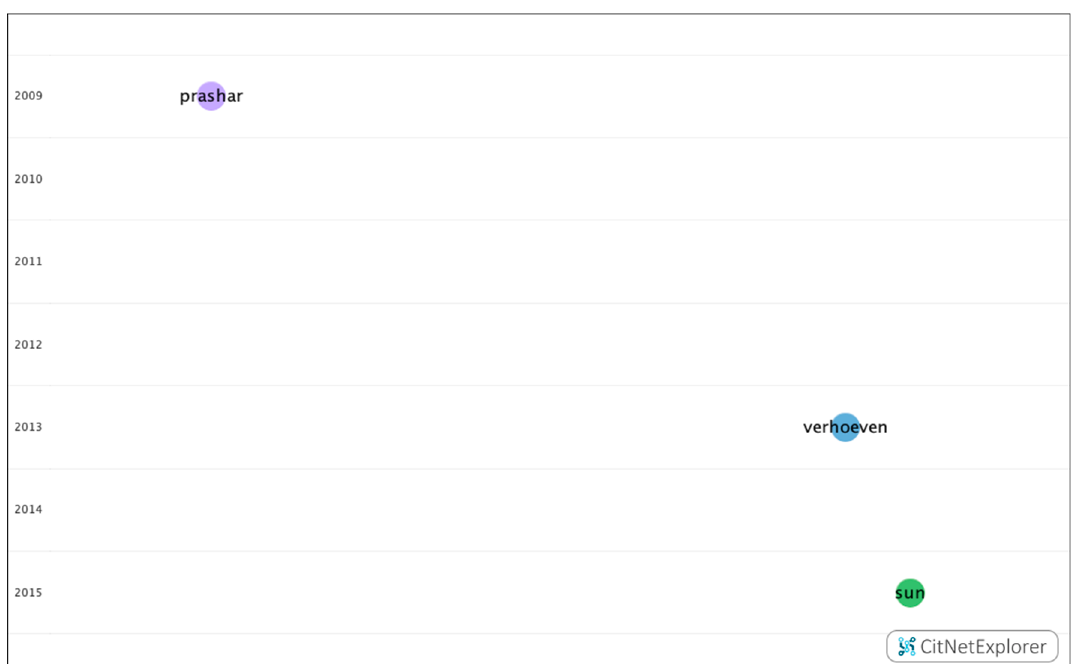
Figure 11. Relationship between the three main groups .